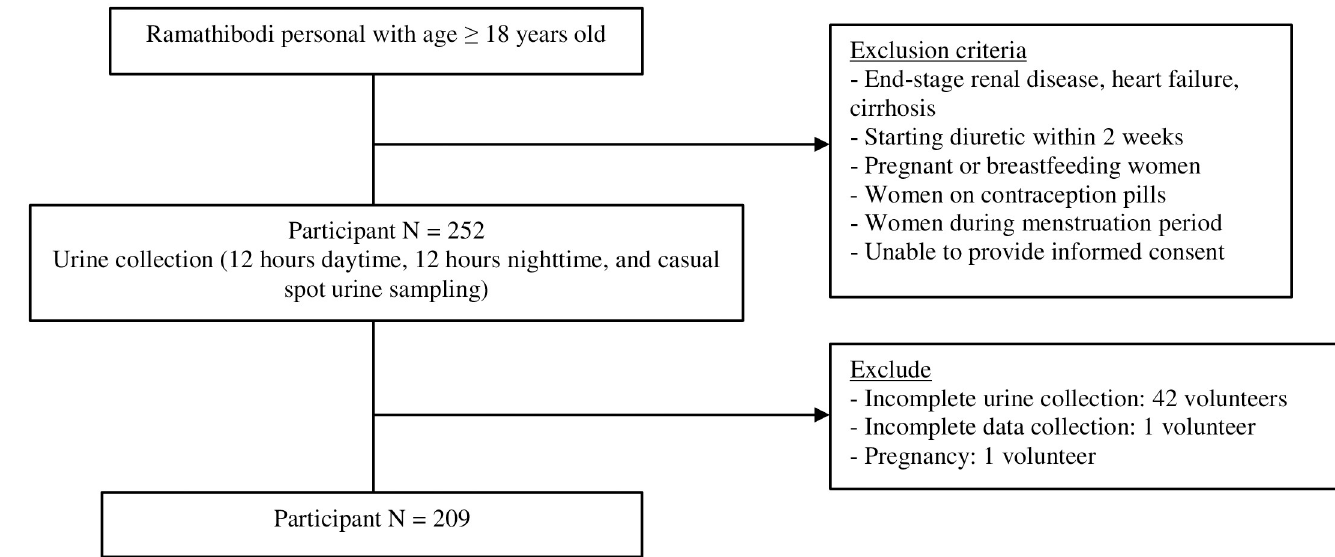
Fig 1. Flow diagram of participants included in the